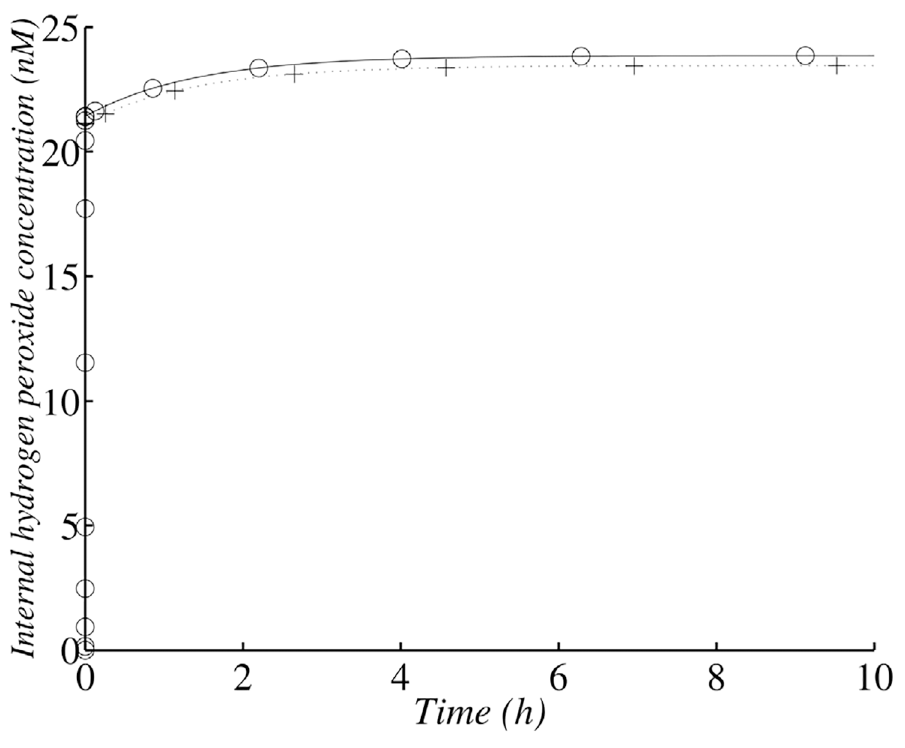
model and a numerical